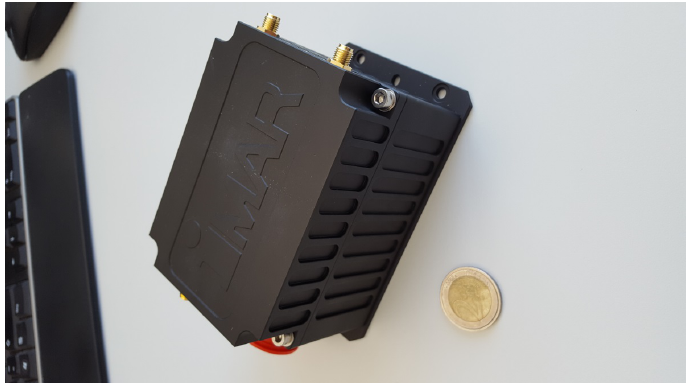
Figure 2: Navigation platform.